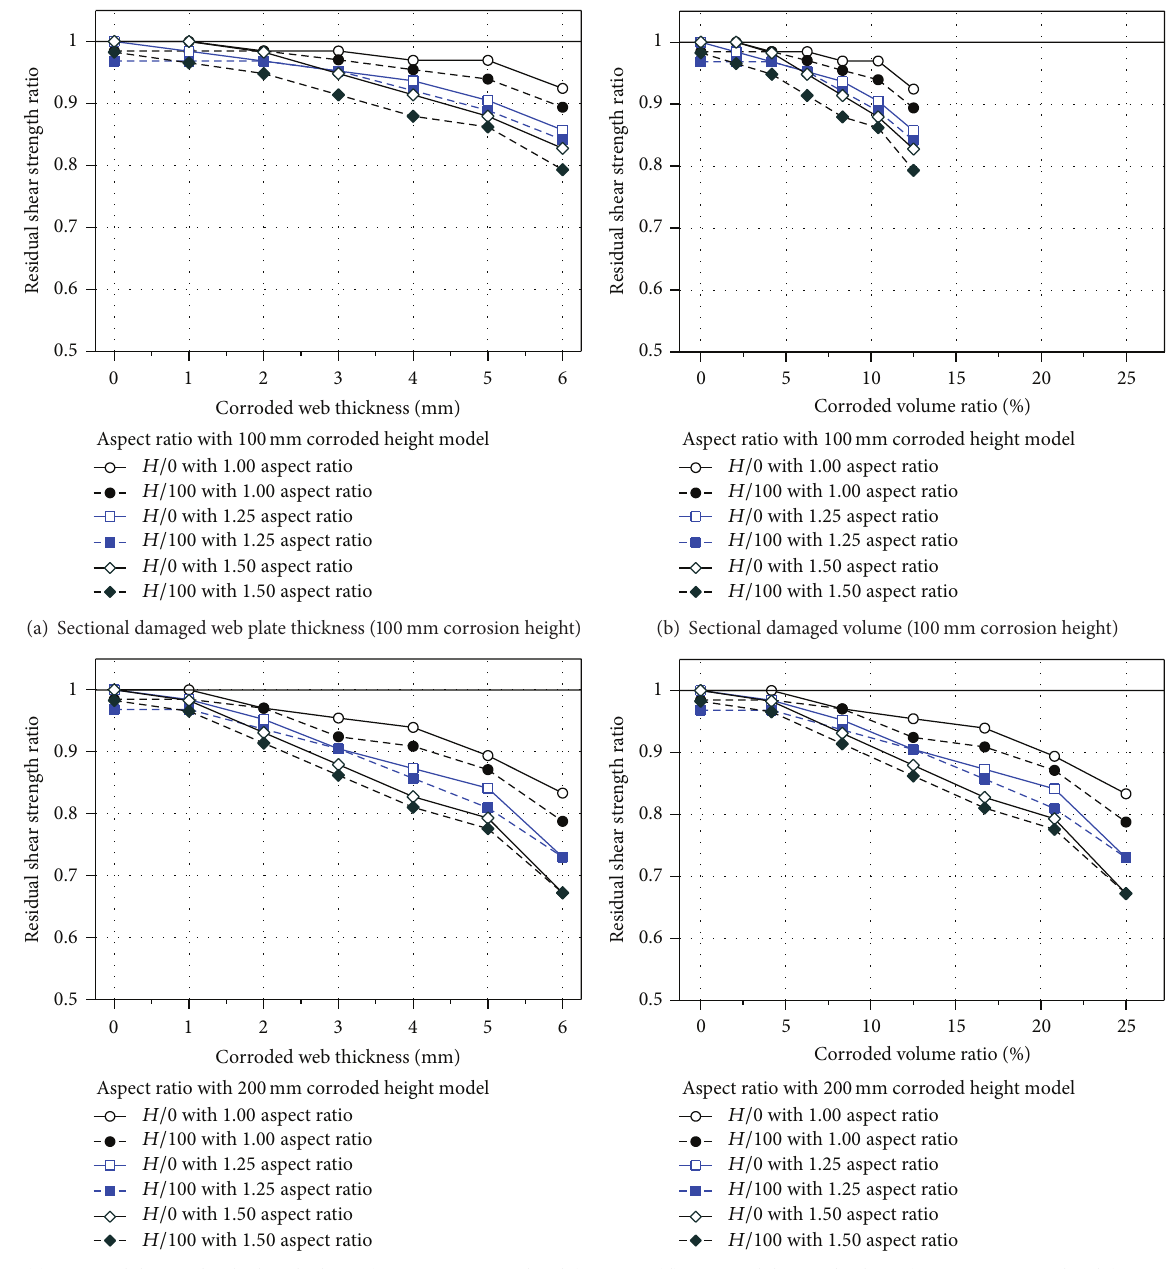
Figure 8: Shear buckling resistance ratios depending on aspect